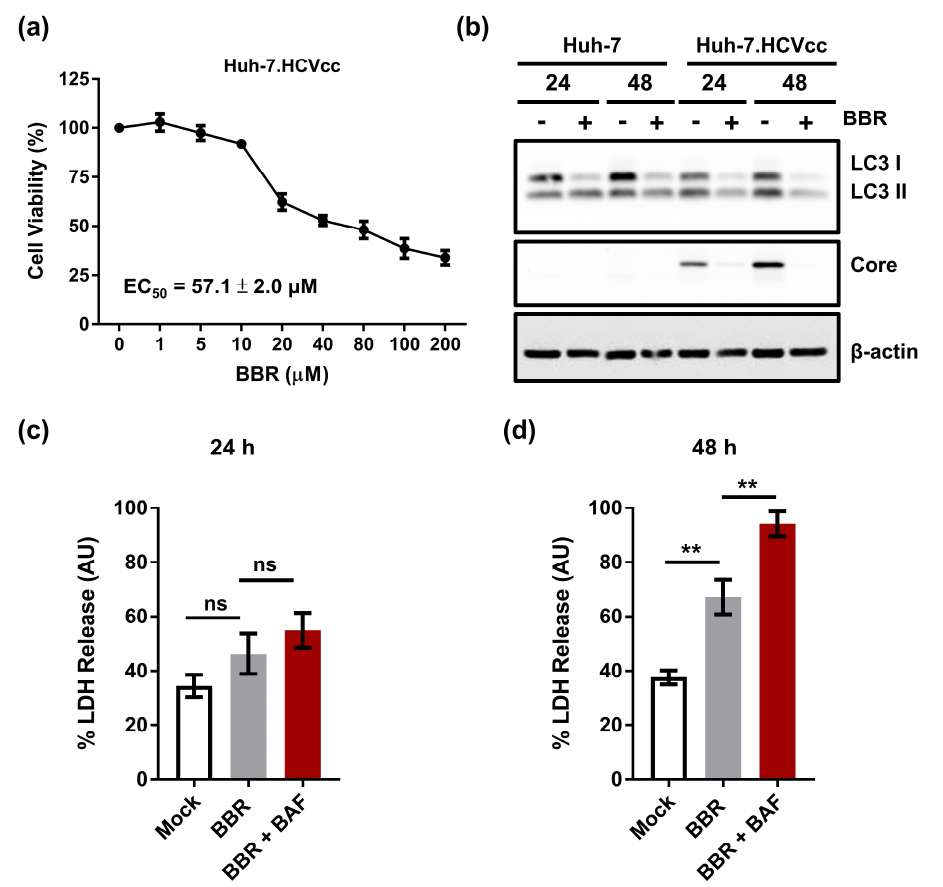
Figure 6. The inhibition of autophagy enhances berberine (BBR)-induced death of cells persistently infected with hepatitis C virus (HCV) particles. ( a ) Huh-7.HCVcc cells were seeded in 96-well plates (2 × 10 4 cells / well) overnight and treated with the indicated concentrations of BBR for 72 h before cell viability analysis. ( b ) Huh-7 and Huh-7.HCVcc cells were seeded in six-well plates and subsequently treated with 100 µ M BBR for 24 or 48 h. Lysates where then collected and subjected to Western blot analysis against microtubule-associated protein 1 light chain 3 (LC3). HCV core expression indicated the presence of infection, and β -actin was used as a loading control. For cell death analysis, cells were seeded in 96-well plates and either left untreated, treated with 100 µ M BBR alone for ( c ) 24 or ( d ) 48 h, or pretreated with bafilomycin A1 (BAF) for 4 h, followed by BBR treatment for 24 or 48 h before lactose dehydrogenase (LDH) release analysis. Results are shown as means ± SD from three independent repeats for all experiments. ** p < 0.01; ns = not